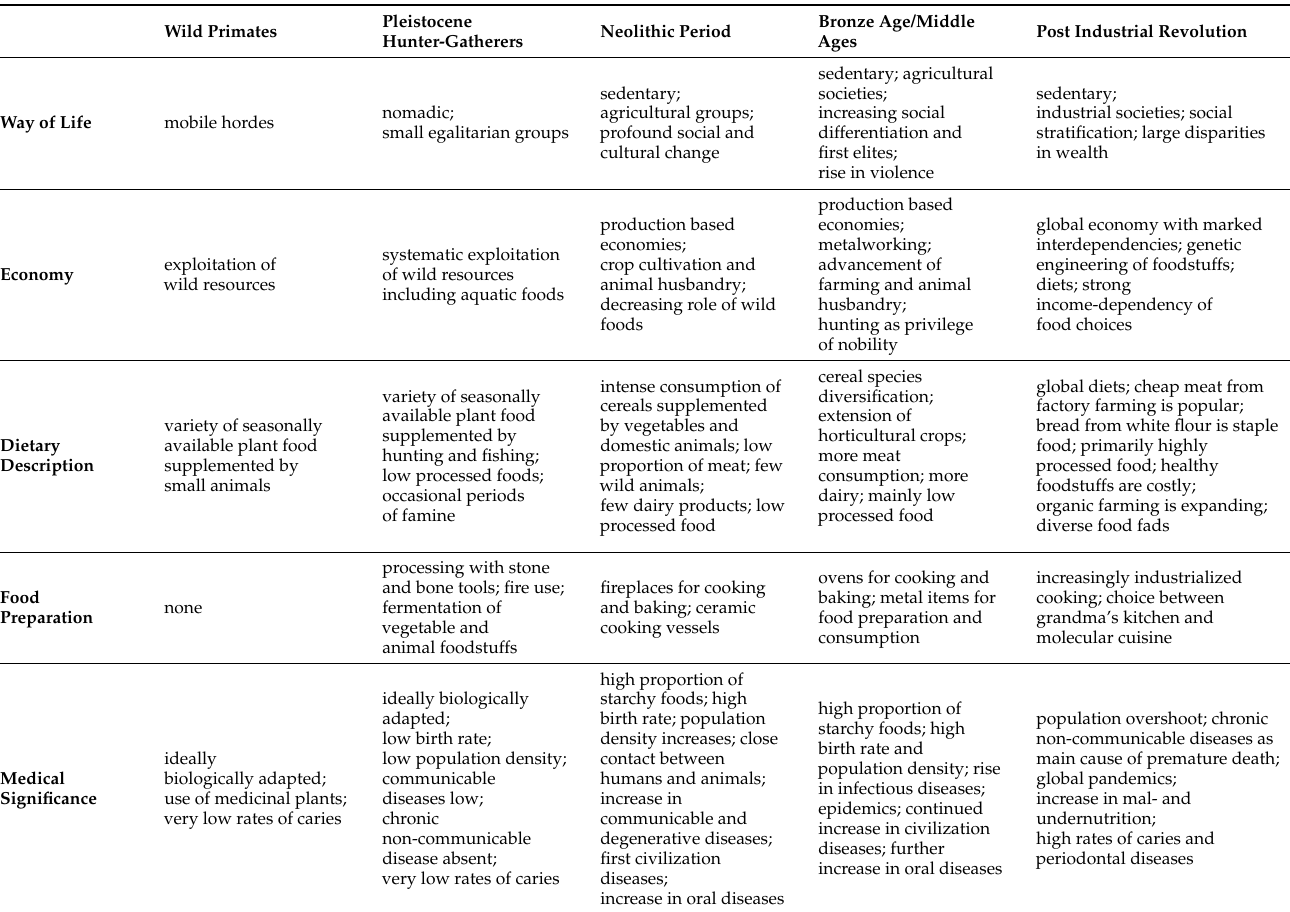
Table 1. Chronological survey of food acquisition and dietary behaviour in nonhuman primates and human groups from prehistory and the Neolithic transition to a farming lifestyle up to the Industrial Revolution and the